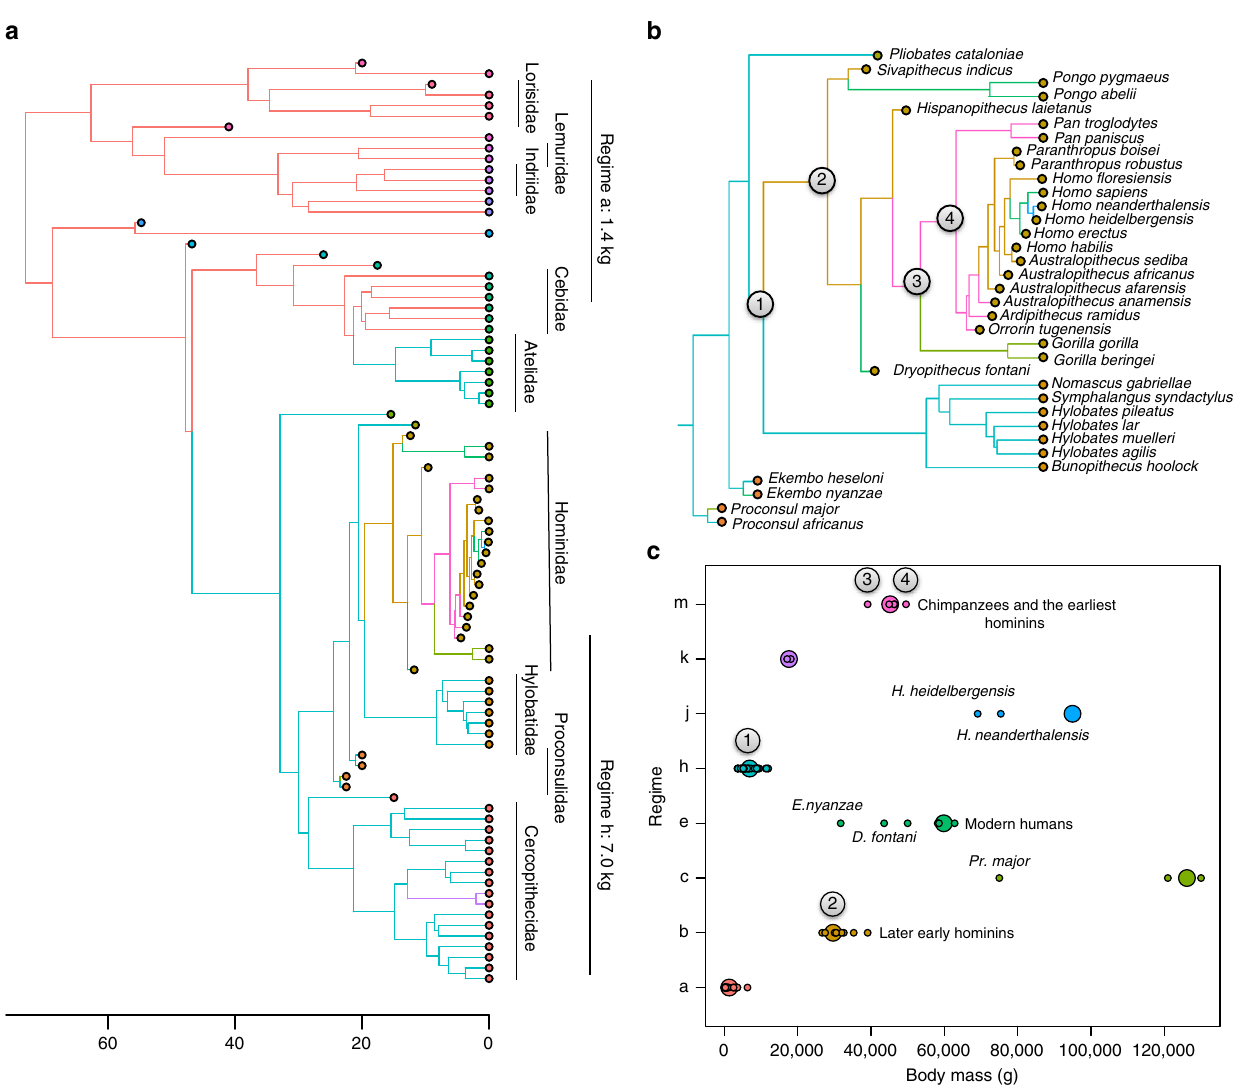
Fig. 1 Time-calibrated phylogenetic tree with selective regimes and estimated body size optima. a Primate phylogenetic tree including fossils with tips color-coded to denote families, major families noted on the right. Phylogeny showing complete species names shown in Supplementary Fig. 1A Colors along branches showing best-supported selective regimes for body mass evolution including convergence and are consistent between a , b and c . Two major selective regimes for primates and optimal body size for each regime shown on far right correspond to Table 2; b focus on hominoids from a including fossil taxa. Marked nodes correspond to last common ancestors of all hominoids (1), hominids (2), African hominids (3), and chimpanzees and humans (4); c body mass averages (smaller circles) and inferred primary adaptive optima (larger circles) for species in each regime for primates including fossils corresponding to a and b . Numbered LCAs match nodes in b . Also noted is the adaptive optima of chimpanzees, the earliest hominins, later early hominins, and modern humans. Named taxa are outliers to their estimated